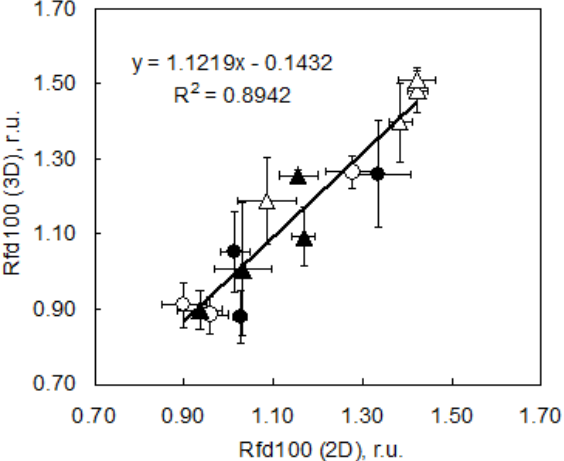
Figure 8. Correlation between Rfd100 parameter measured under low actinic light exposure (100 μ mol (photons) m − 2 ·s − 1 , 120 s) by conventional 2D imaging fluorometer FluorCam and by projection of fluorescence emission on 3D computer reconstruction of plants . The data points represent well watered plants in high light (HW, [ ○ ], 450 μ mol (photons) m − 2 ·s − 1 of PAR, 100% pot water capacity), water stressed plants in high light (HS, [ ● ] 450 μ mol (photons) m − 2 ·s − 1 of PAR, 30% pot water capacity), well watered in low light (LW, [ Δ ] 85 μ mol (photons) m − 2 ·s − 1 of PAR, 100% pot water capacity), water stressed plants in low light (LS, [ ▲ ] 85 μ mol (photons) m − 2 ·s − 1 of PAR, 30% pot water capacity), r.u. stands for relative